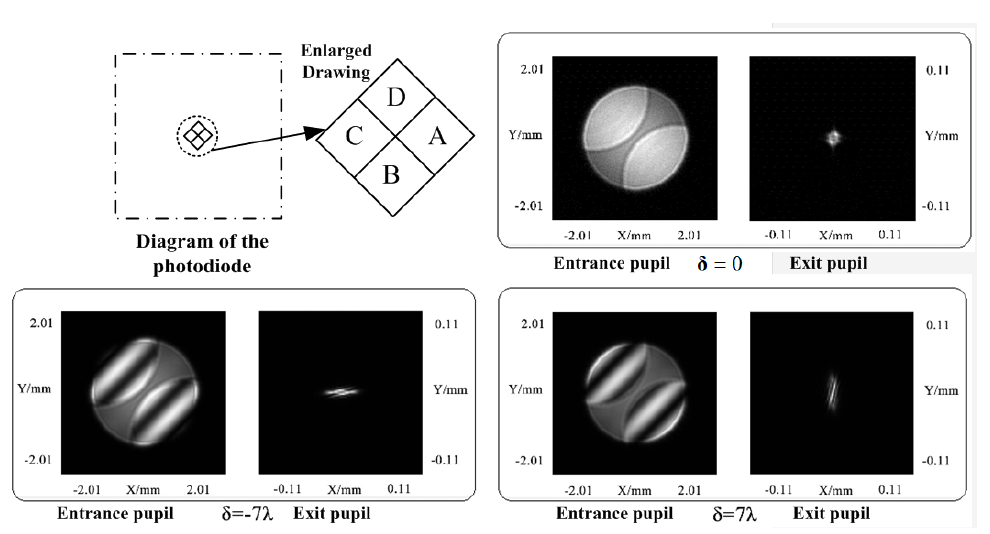
Figure 6. Light intensity distribution of the reflected beam at the entrance pupil (left one in subplot) of spherical lens and the exit pupil (right one in subplot) of cylindrical lens with a different defocus distance. δ  is the defocus distance. λ is the wavelength.